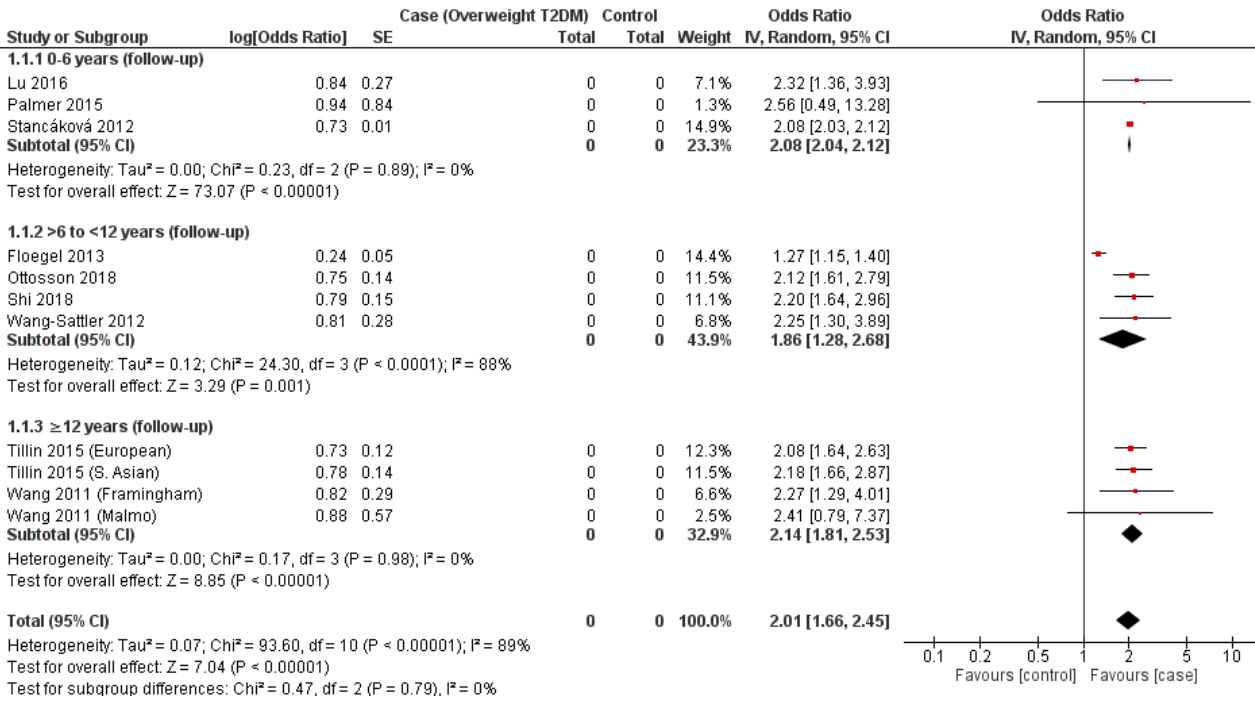
Figure 1. Forest plot depicting the effect sizes of the individual studies for valine in each of the designated temporal subgroups [29–31,41–46].